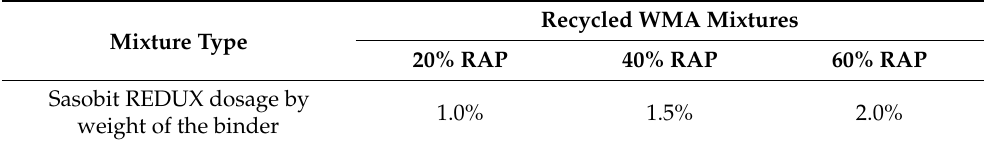
Table 12. Sasobit REDUX dosage within the recycled WMA